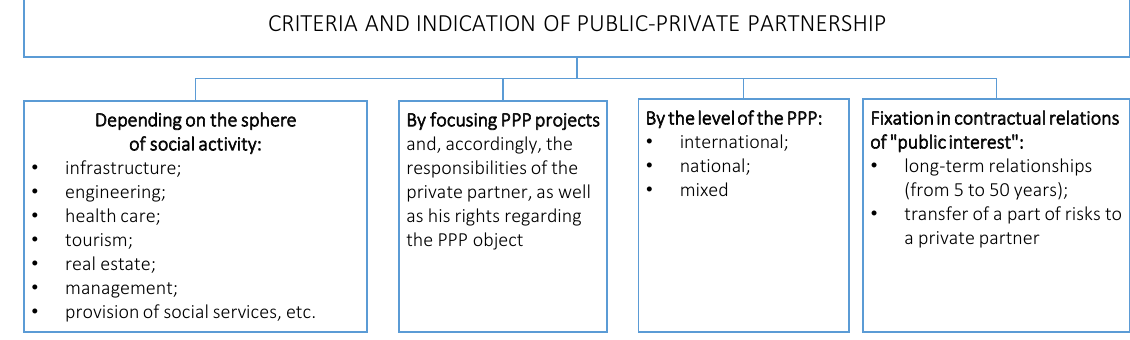
CRITERIA AND INDICATION OF PUBLIC-PRIVATE